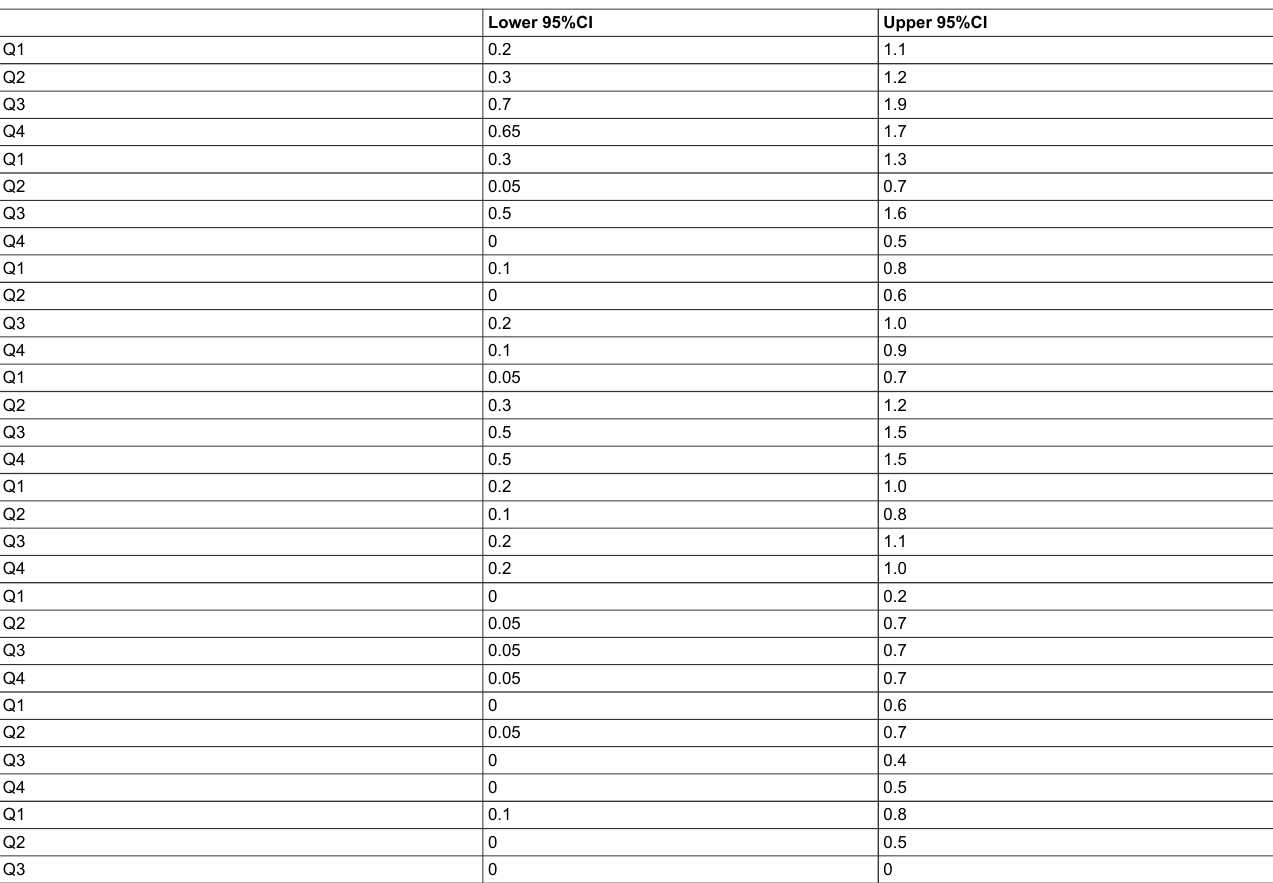
Table S8: 95% confidence intervals for figure